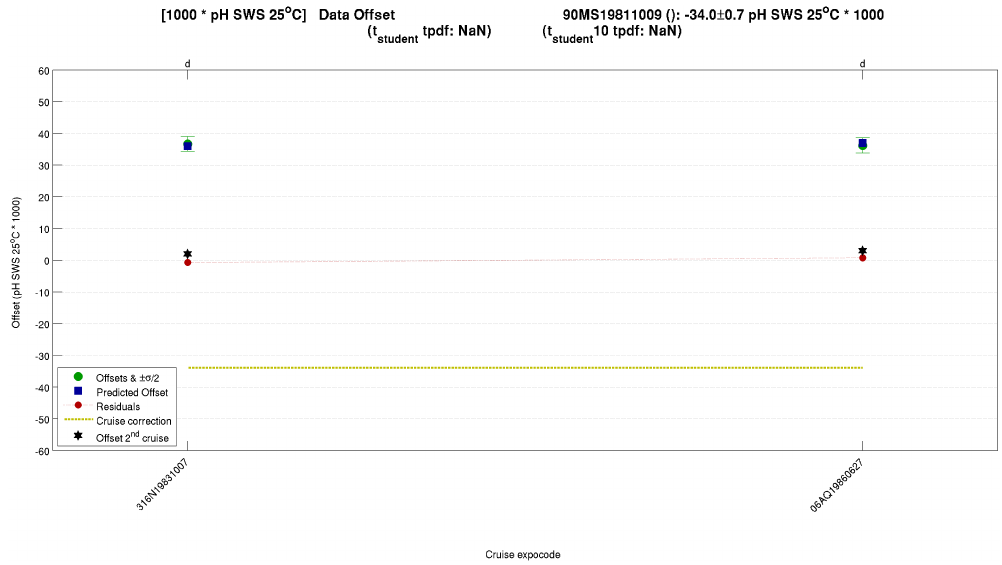
Figure 25. Cruise crossover information plot for 90MS19811009.